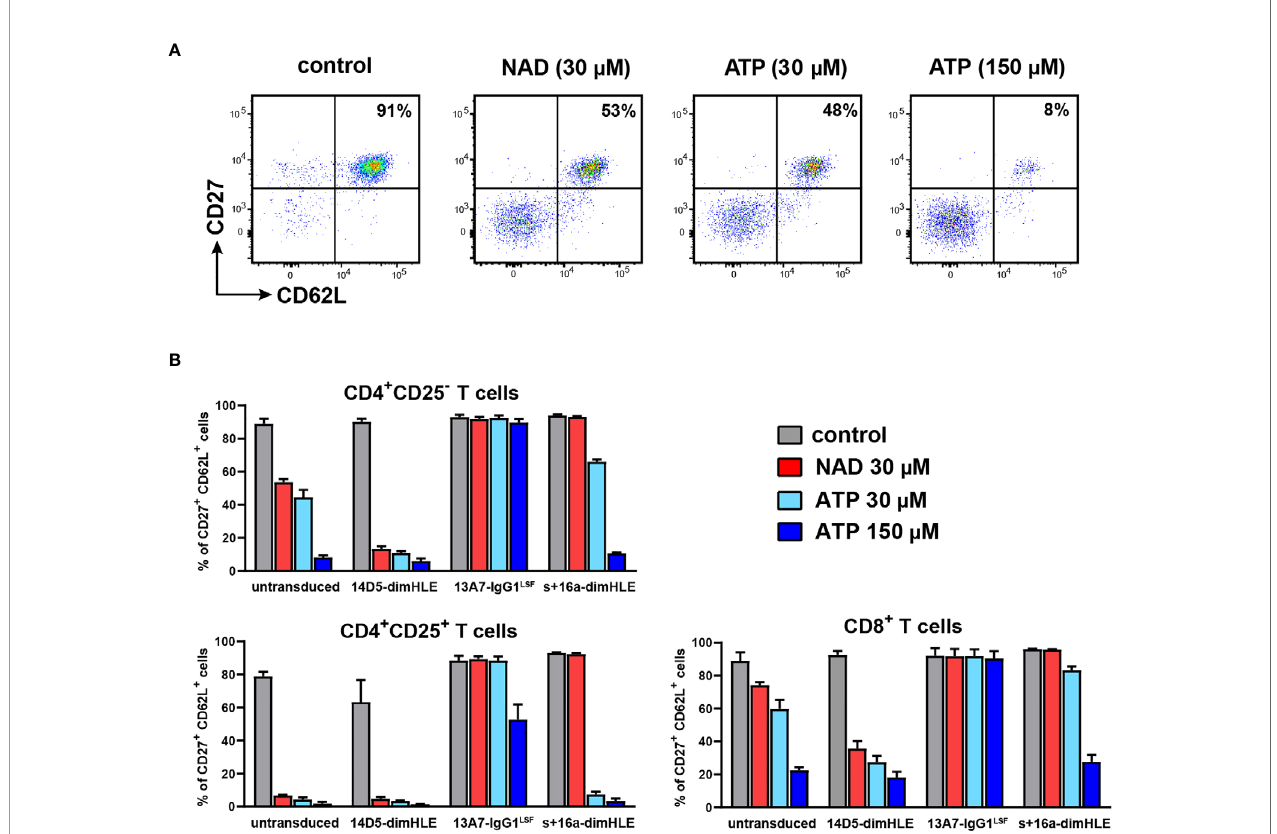
FIGURE 3 | AAVnano modulate P2X7-dependent shedding of CD27 and CD62L ex vivo. C57BL/6 mice were injected i.m. with PBS (control) or with rAAV1 encoding P2X7-potentiating 14D5-dimHLE, P2X7-blocking 13A7-IgG1 LSF hcAb or ARTC2.2-blocking s+16a-dimHLE. Blood samples were collected at different time points ranging from day 17 to day 120 after rAAV injections. Cells were then incubated for 15 min at 37°C with PBS, 30 µM ATP, 150 µM ATP or 30 µM NAD + to induce P2X7- dependent shedding of CD27 and CD62L on T cells. Representative results obtained 30 days after rAAV injection are shown. (A) Representative fl ow cytometry plots illustrating shedding of CD27 and CD62L on gated CD4 + CD25 - T cells harvested from control mice. Numbers indicate percentages of CD27 + CD62L + cells. (B) Mean percentages of CD27 + CD62L + cells among gated CD4 + CD25 + , CD4 + CD25 - and CD8 + T cells after incubation with PBS (grey), 30 µM NAD + (red), 30 µM ATP (cyan) or 150 µM ATP (blue). Staining was performed using fl uorochrome conjugated antibodies speci fi c to CD45 (coupled to APC-Cy7), CD4 (FITC), CD8 (PE-Cy7), CD25 (PE), CD27 (PerCP-Cy5.5) and CD62L (APC). Errors bars represent the SEM,